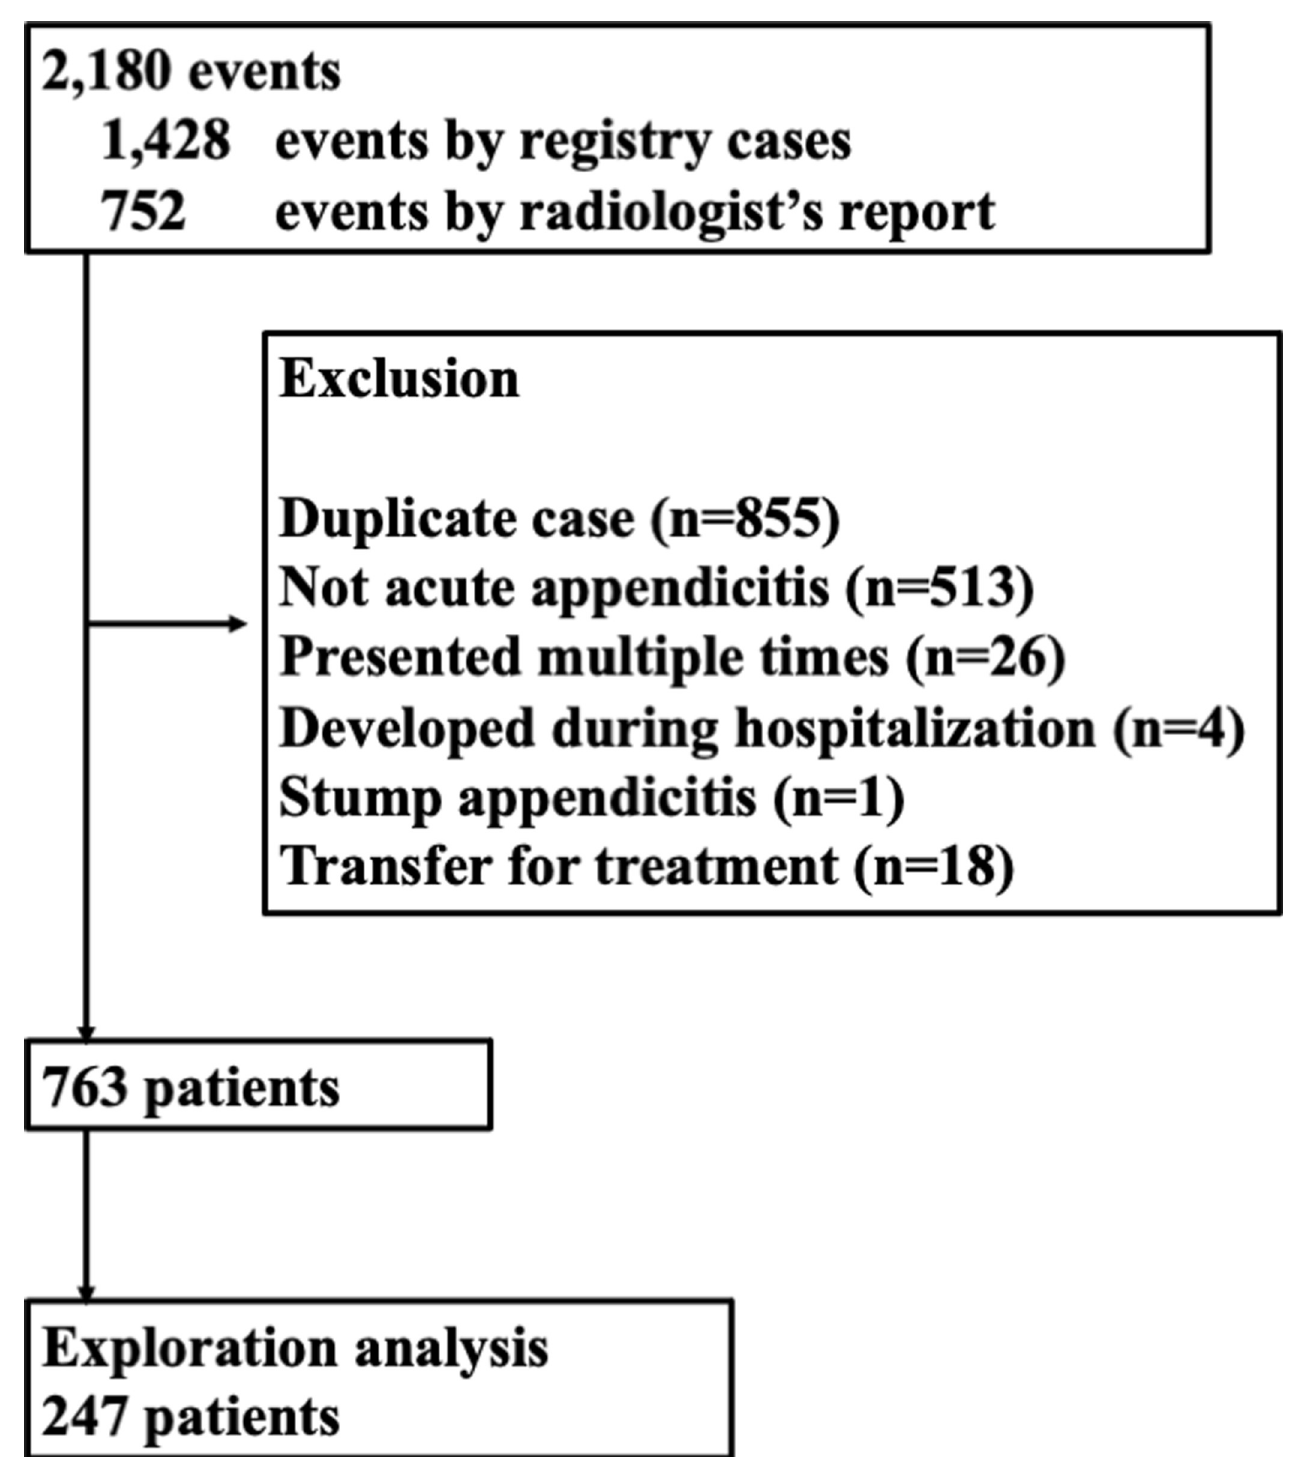
Fig 1. Flow chart of patient selection.